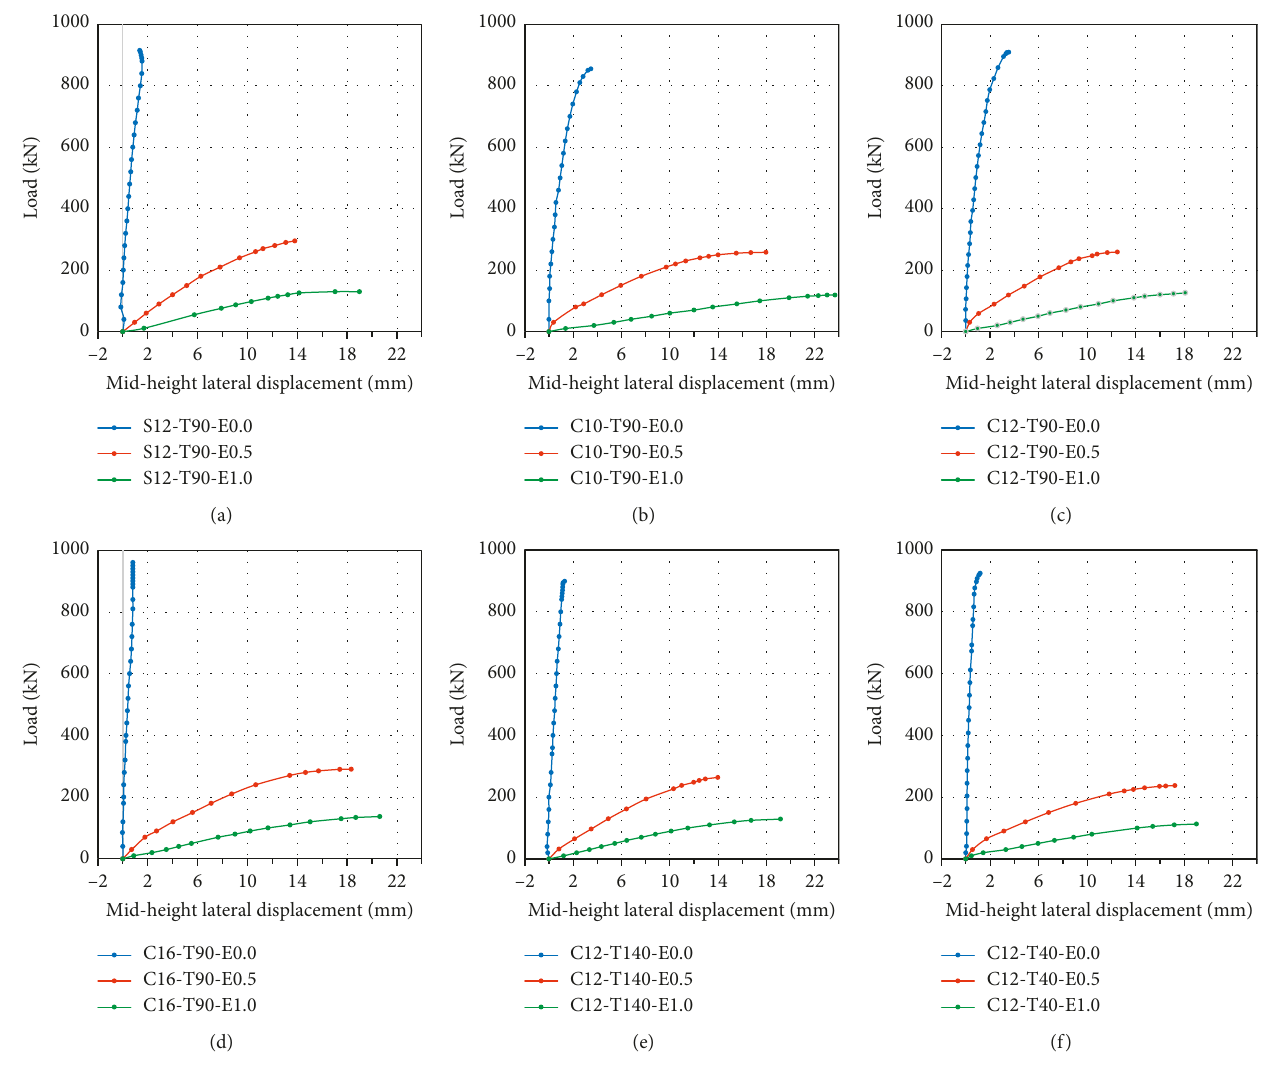
Figure 7: Load-lateral deflection curves at midheight of the